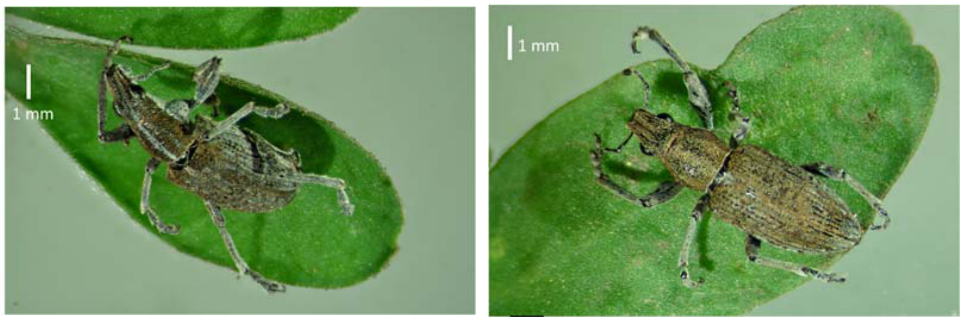
Figure 1. Charagmus gressorius ( left ) and Charagmus griseus ( right